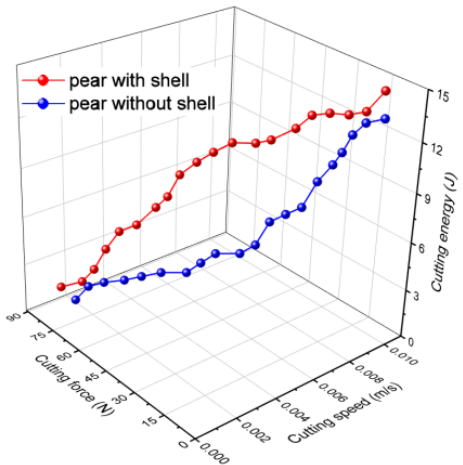
Figure 8. Variation in cutting energy for peeled and unpeeled pears with different humidity levels as a function of cutting speed.